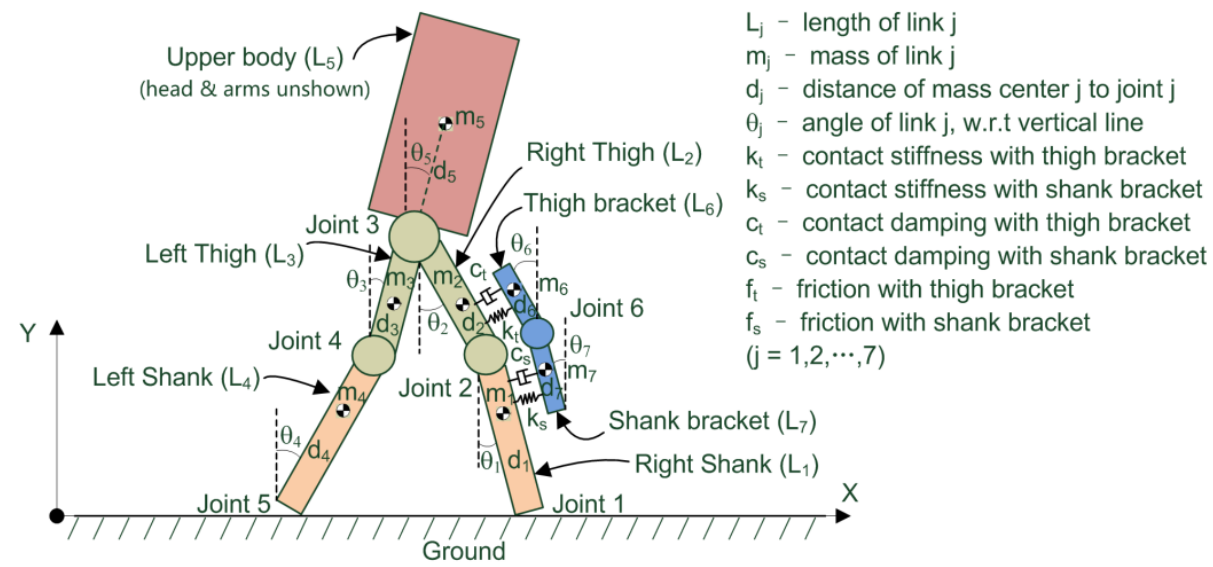
Figure 3. Simplified (5 + 2)-link dynamic model for the human-exoskeleton system, with link parameters and major contact parameters listed and shown in the sagittal plane. Note: the double support phase is presented here, where both feet have ground contact. For the single-support phase, only one foot has ground contact, while the other foot swings in the air.